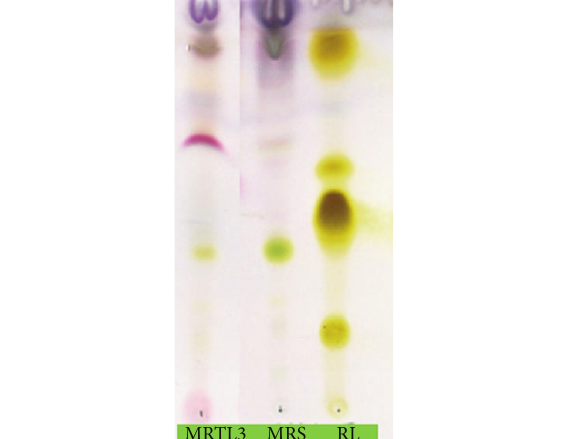
Table 3: Chemical shift assignment of biosurfactant in 1H NMR. Assignment